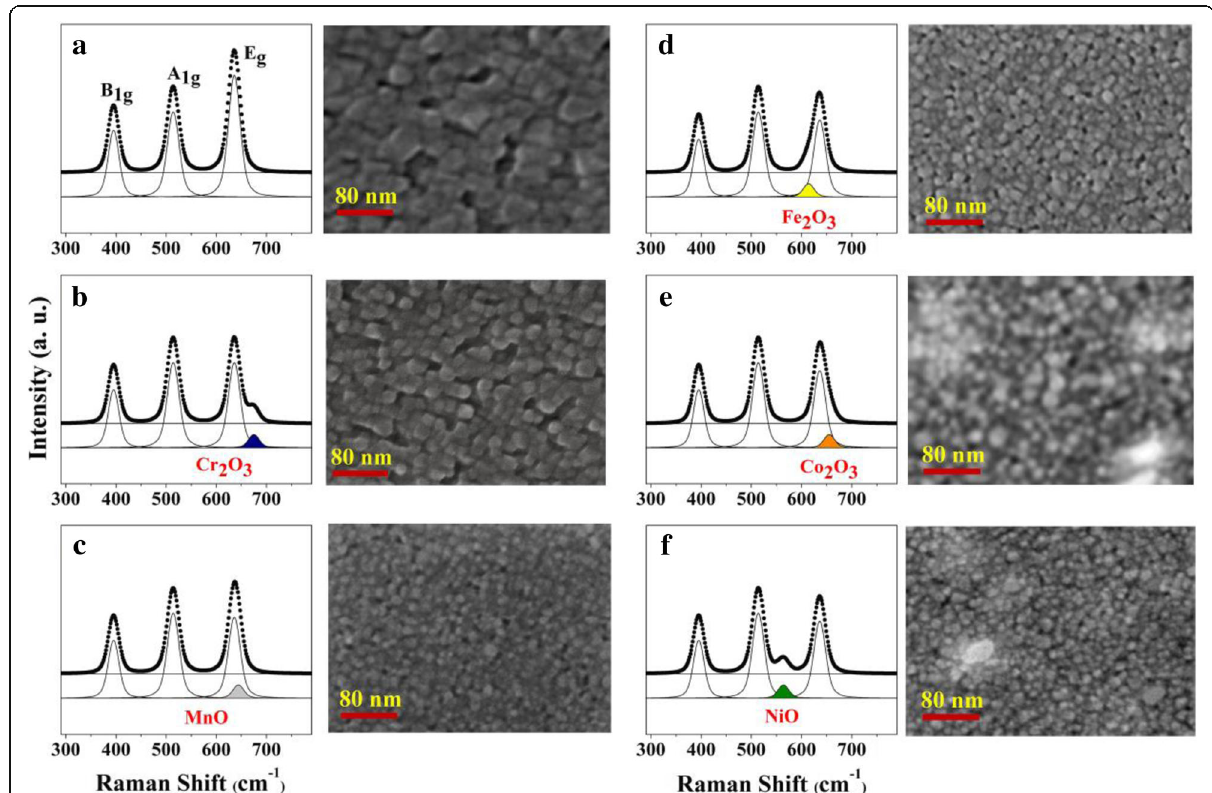
Fig. 2 The Raman spectra of monodisperse 5 mol% TM-TiO 2 : a anatase TiO 2 , b Cr-TiO 2 , c Mn-TiO 2 , d Fe-TiO 2 , e Co-TiO 2 , and f Ni-TiO 2 and the corresponding SEM images,